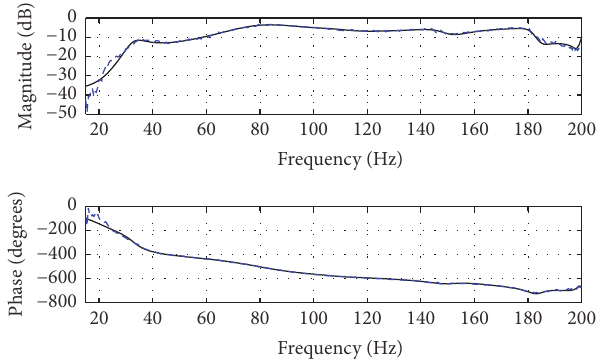
Figure 4: Frequency response curves of VA15 experiment